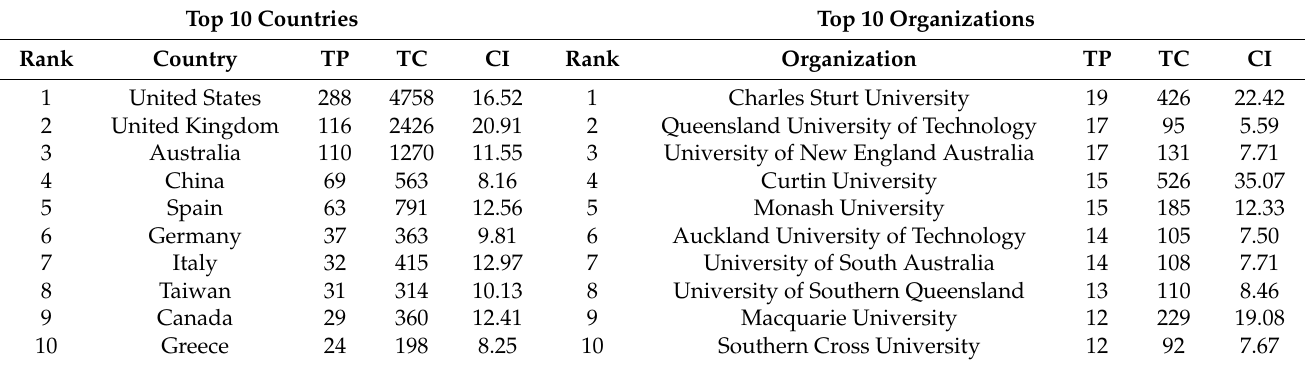
Table 1. Leading countries and